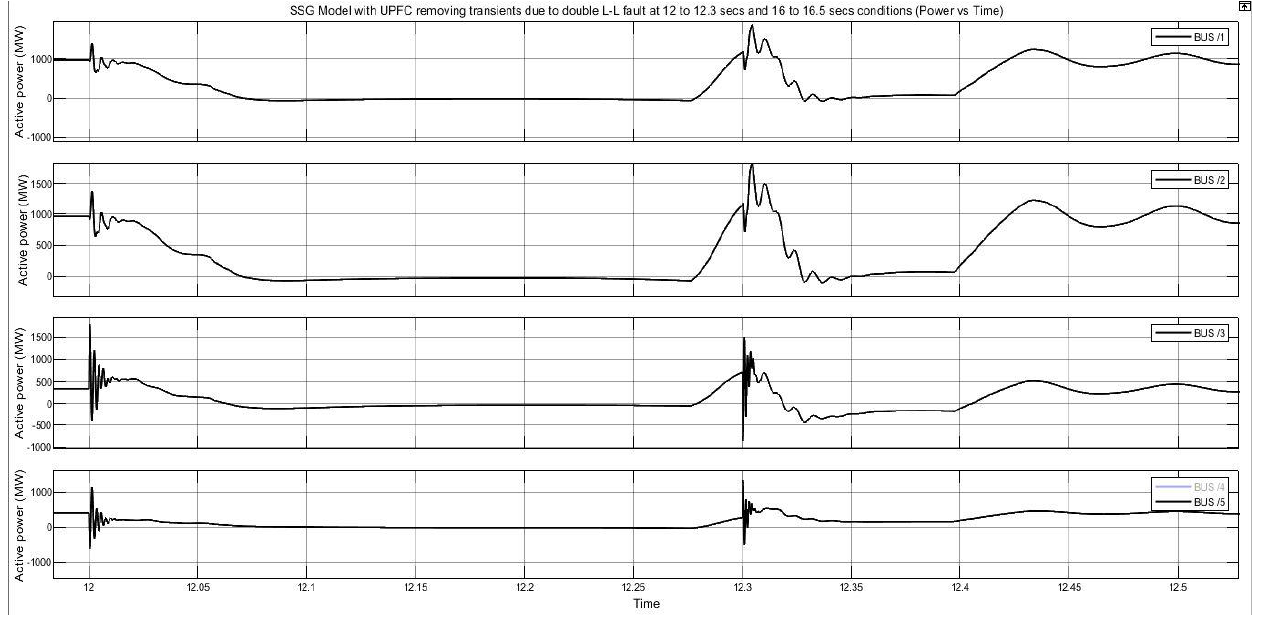
Figure 27. Transient stability being provided by UPFC after multiple double faults L-L introduced 12 to 12.3 s (Bus 1 to Bus 5).